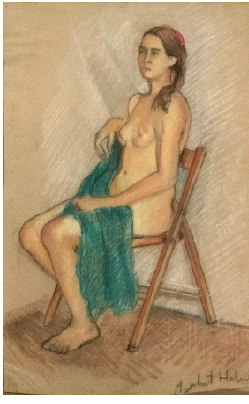
Figure 3. Menhat Helmy, Untitled. Semi-Nude Portrait (1947–1949). Courtesy of estate of Menhat Helmy.